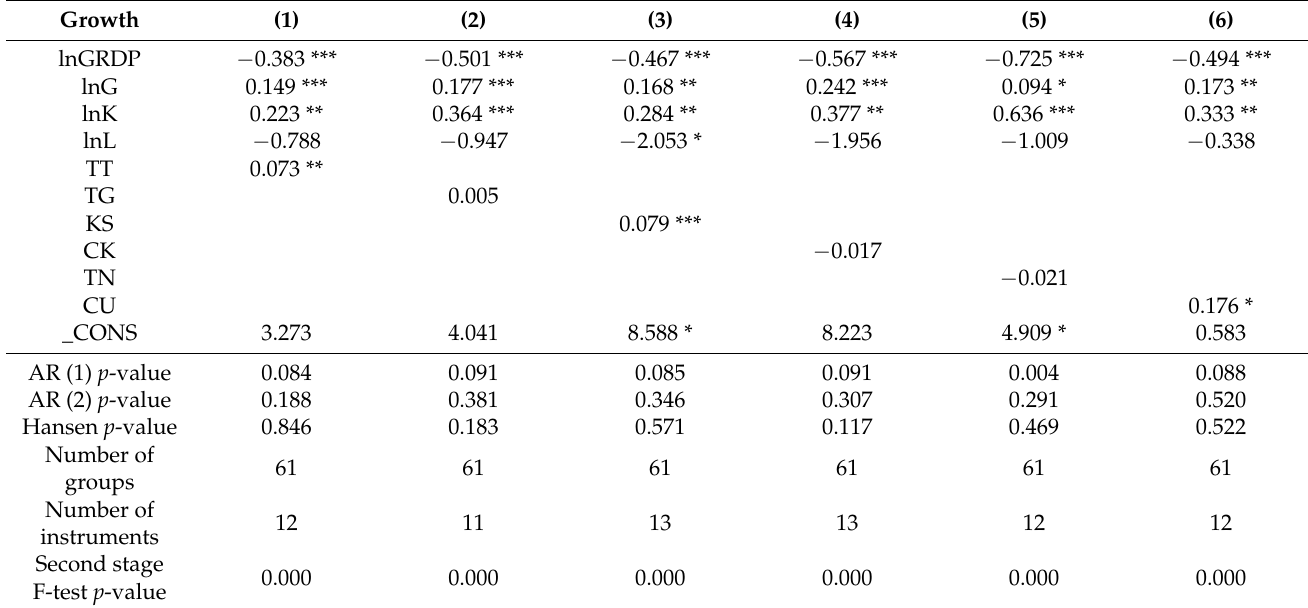
Table 4. Estimation result by the SGMM